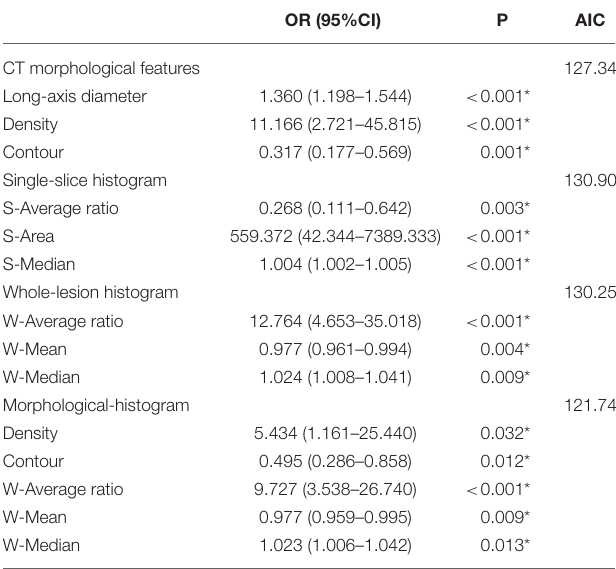
TABLE 3 | Comparison of the models by multivariate logistic regression